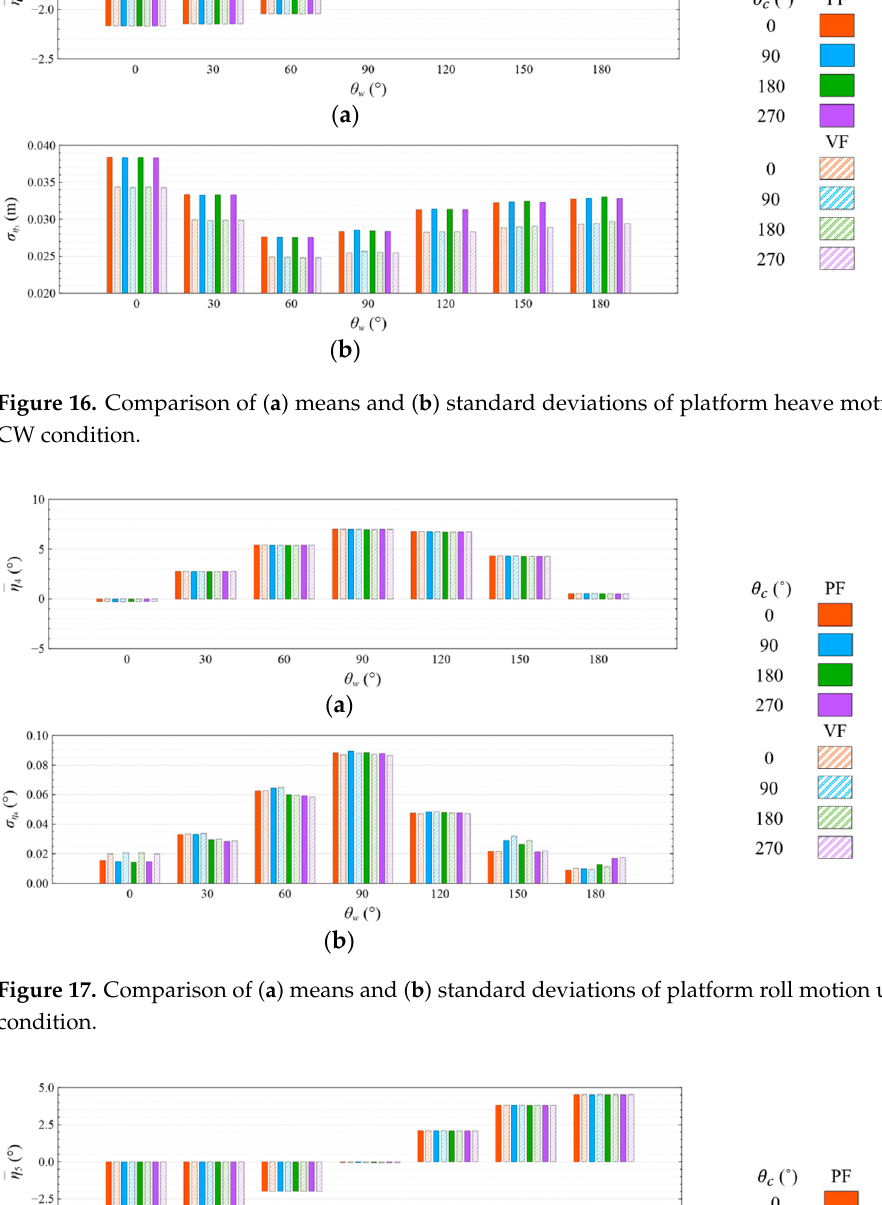
Figure 15. Comparison of ( a ) means and ( b ) standard deviations of platform sway motion under CW condition.